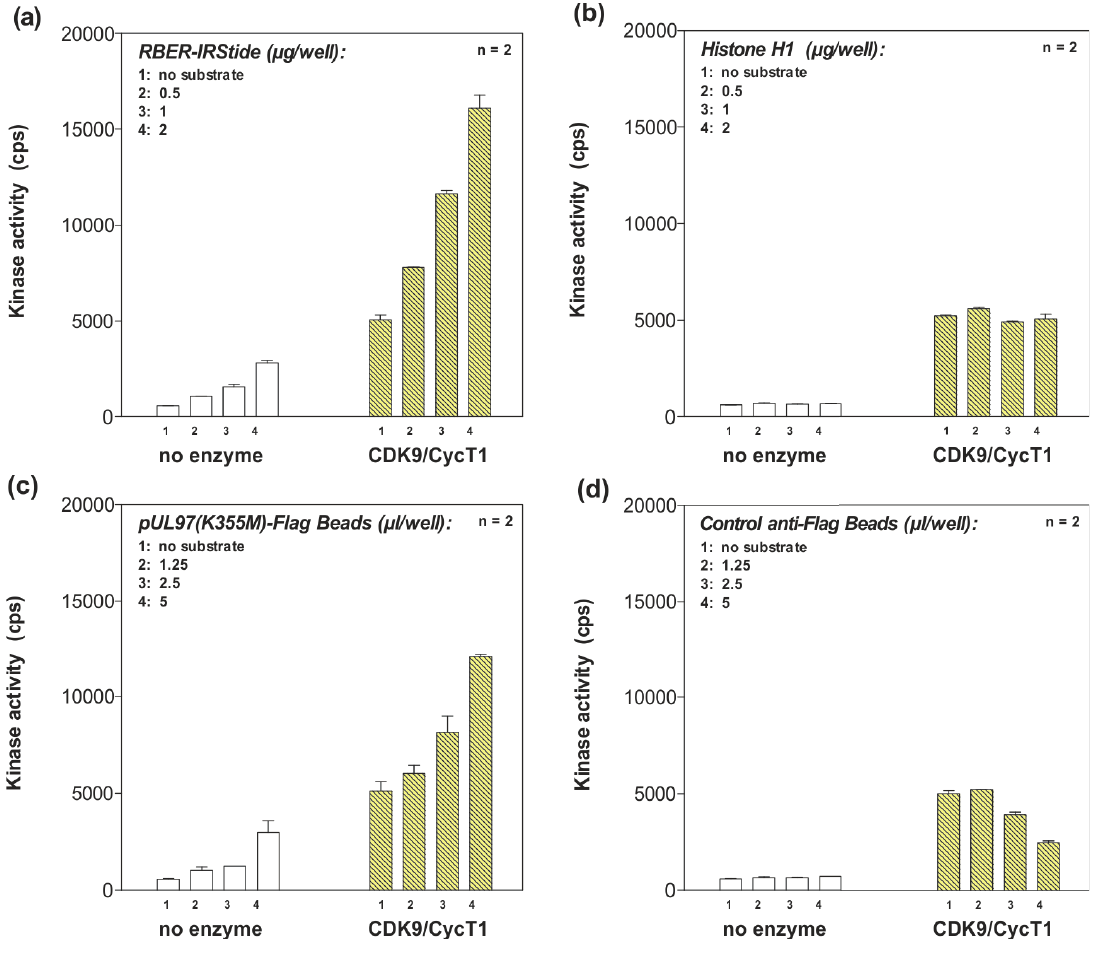
Figure 6. ATP consumption assay used to investigate the putative phosphorylation of pUL97 by the CDK9/cyclin T1 complex. The catalytically inactive mutant pUL97(K355M)-Flag was expressed in 293T cells and 2 days post-transfection, immunoprecipitated from cell lysates using mAb-Flag. Immunoprecipitates and mAb-Flag coated protein A sepharose beads (negative control) were used to determine luminescence signals (counts per second (cps)) as a measure for ADP generation by the active CDK9/cyclin T1 complex; the assay was performed in duplicate (n = 2). ( a ) Specific substrate RBER-IRStide (positive control); ( b ) substrate bovine histone H1 (negative control); ( c ) pUL97(K355M)-Flag (substrate in question); ( d ) mAb-Flag coated protein A sepharose beads (negative control). All substrates were used in increasing